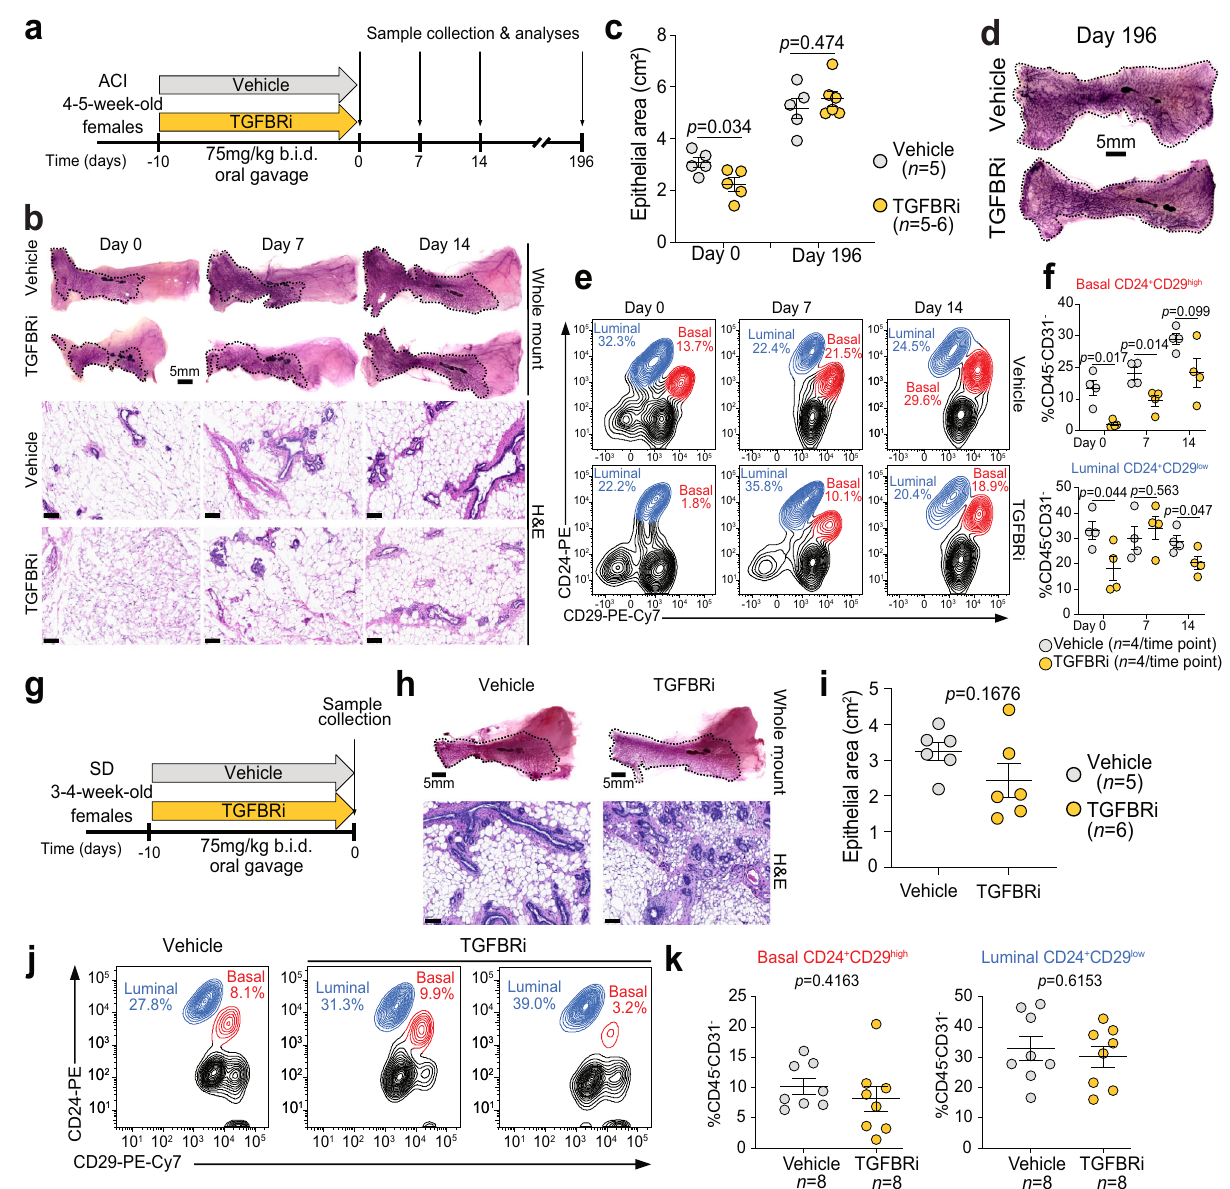
Fig. 1 | The effect of peripubertal TGFBRi treatment on mammary glands of peripubertalACI andSDrats.a Schematic outline of experimentaldesign for ACI rats. b – d Representativemammaryglandwholemounts( b , d ),quanti fi cationofthe epithelial area ( c ), and hematoxylin and eosin (H&E) staining of mammary tissue sections ( b ) from ACI rats at indicated experimental timepoints ( n =5 for vehicle and for TGFBRi n =5 at day 0 and n =6 at day 196). e , f Representative fl ow